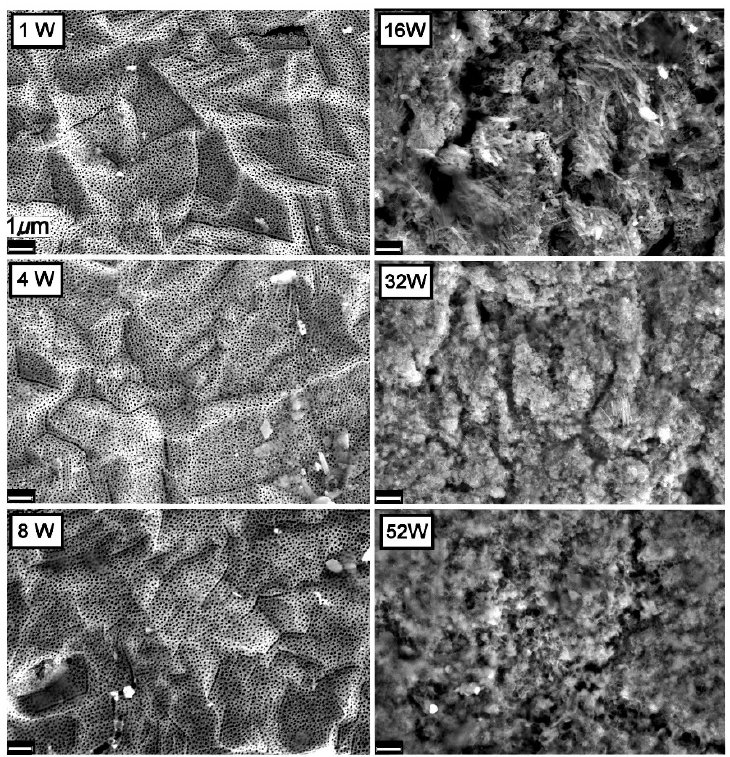
Figure 5. Changes observed on the surface of the TiO 2 NT-O samples when exposed to synthetic greywater under atmospheric conditions.